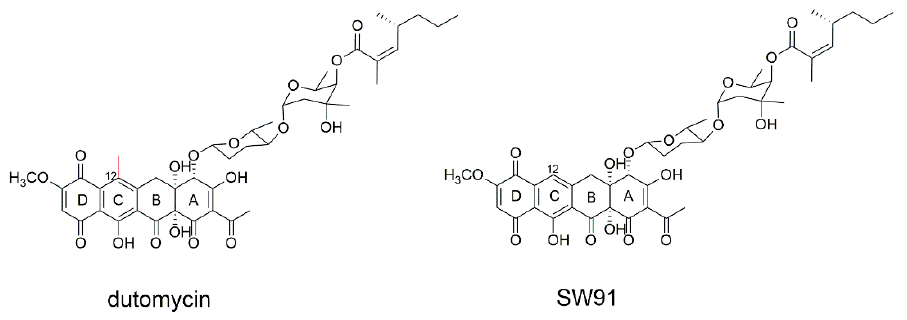
Figure 1. The structure of dutomycin and SW91.